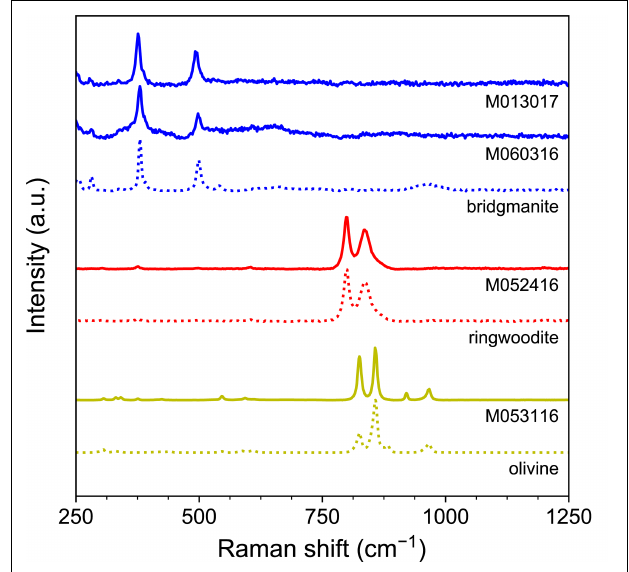
FIGURE 3 | Experimental pressures and temperatures with respect to the geotherm. The temperatures of the experiments (open circle with error bars) are near the estimated mantle temperatures (solid, Stixrude and Lithgow-Bertelloni, 2011) and fall between the melting curve of iron (dashed dotted, fitted from Williams et al., 1987) and the eutectic melting curve of Fe–C binary system (dashed, fitted from Hultgren et al., 1963; Hirayama et al.,